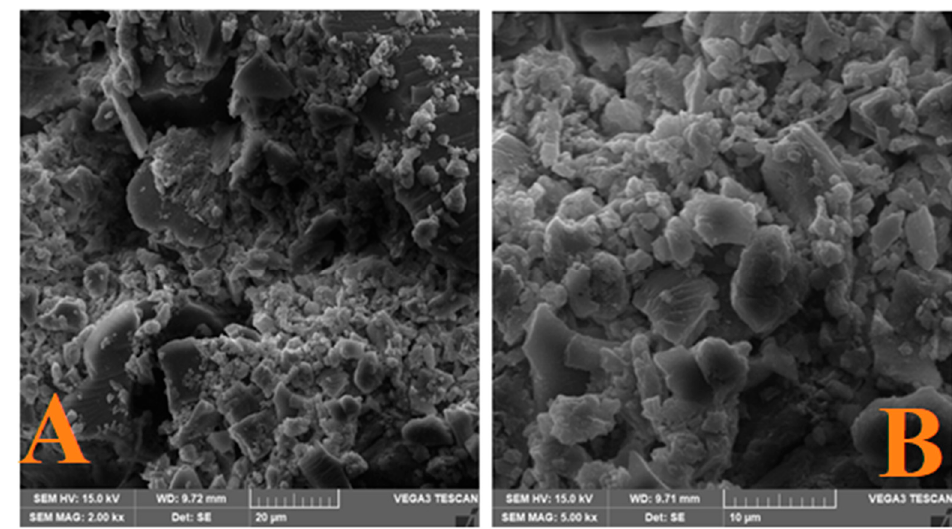
Figure 4 . The SEM Images of CuONPs at ( A ) 20 µm and ( B ) 10 µm Figure 4. The SEM Images of CuONPs at ( A ) 20 µ m and ( B ) 10 µ m.